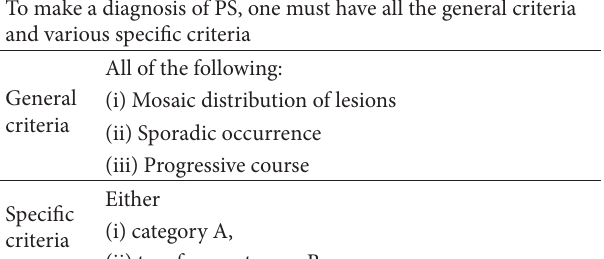
Table 1: Revised Proteus syndrome diagnostic criteria (Turner et al., 2004)